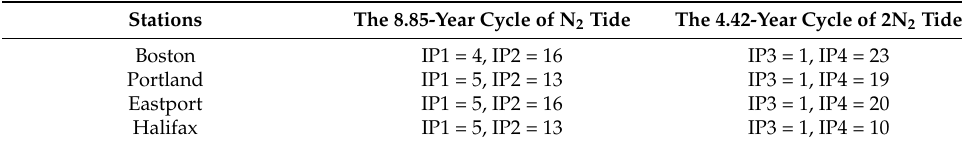
Table 6. The best-fit numbers of IPs for the 8.85-year cycle of N 2 tide and the 4.42-year cycle of 2N 2 tide at 4 stations. The IP1 and IP2 represent the numbers of IPs for the 18.61- and 8.85-year cycles of N 2 tide. The IP3 and IP4 represent the numbers of IPs for the 8.85- and 4.42-year cycles of 2N 2 tide.